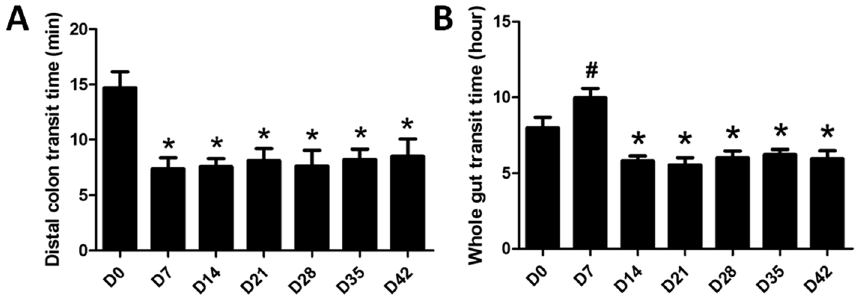
Figure 2. Variation of distal colon transit time (dCTT) ( A ) and whole gut transit time (WGTT) ( B ) in DSS- induced colitis rats. Both * and # P < 0.05 compared with Day 0. (N = 8).